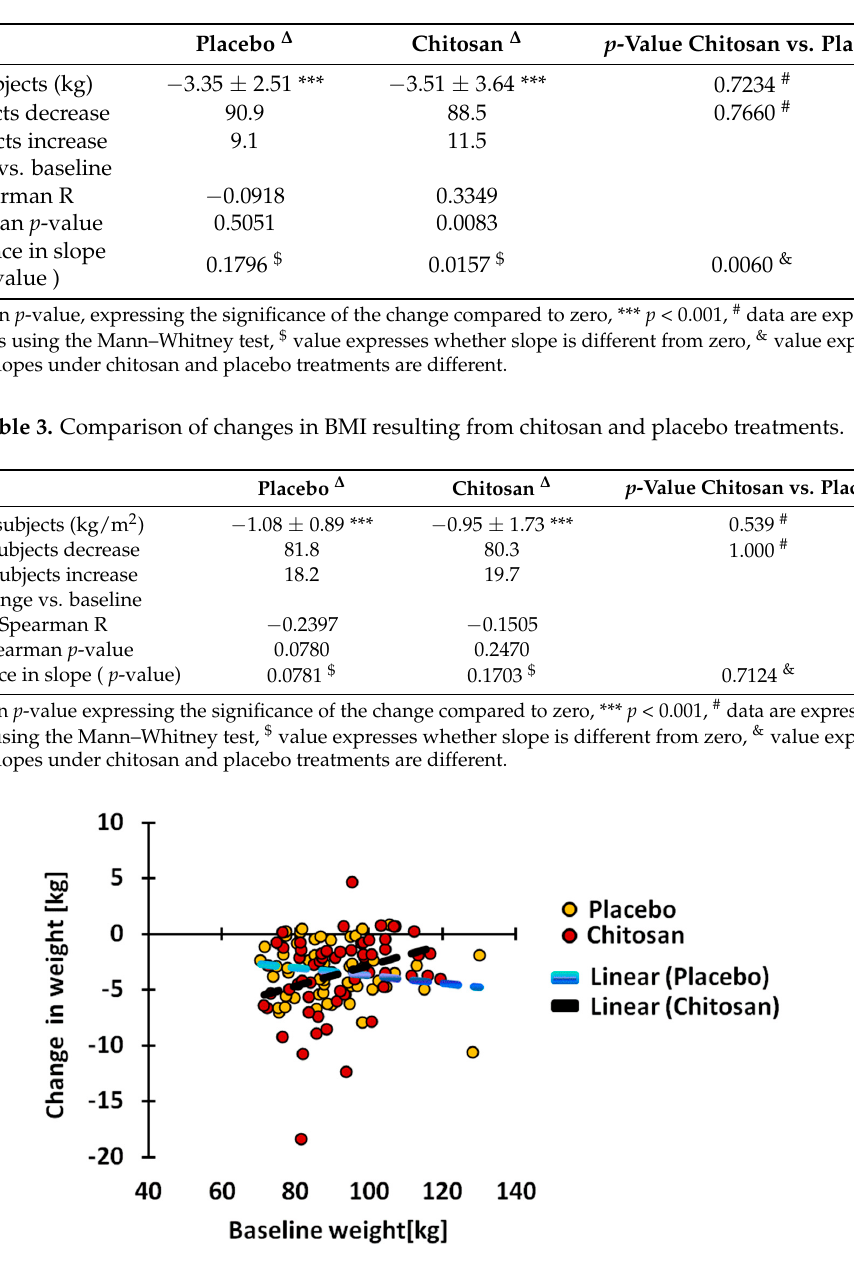
Table 2. Comparison of changes in body weight induced by chitosan and placebo treatments.